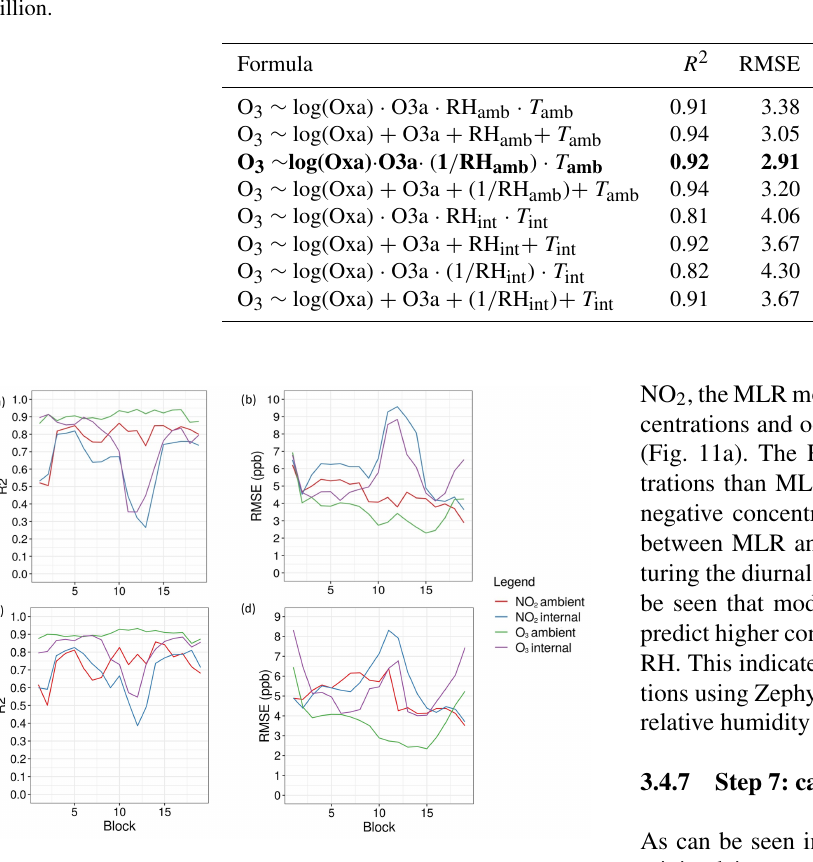
Figure 9. (a) R 2 and (b) RMSE over the 19 test blocks for the MLR models (1a, 1b, 3a, 3b). (c) R 2 and (d) RMSE over the 19 blocks for the RF models (2a, 2b, 4a,